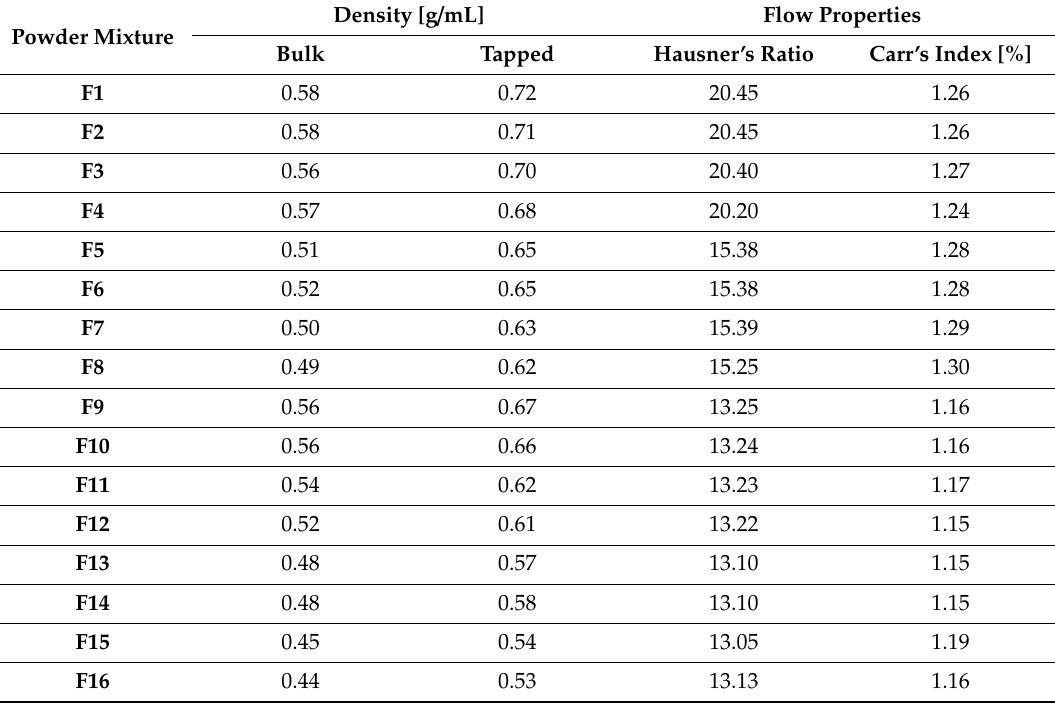
Table 3. Characteristics of tableting